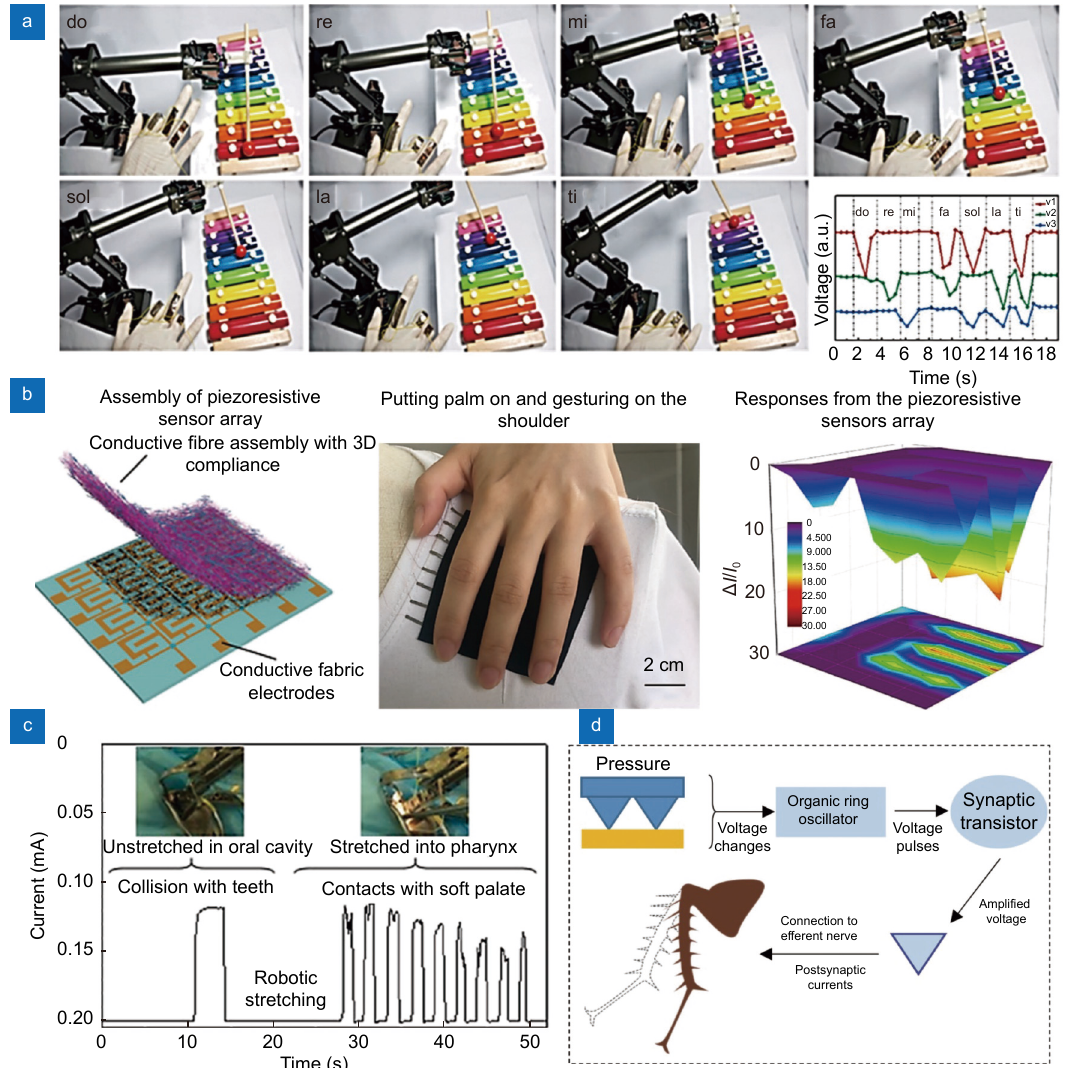
Fig. 13 | Piezoresistive sensor for prosthetics and robots. ( a ) Manipulating the robot arm by a piezoresistive sensor for music playing 169 . ( b ) Large-area force distribution detected by fibre piezoresistive sensor array 171 . ( c ) Piezoresistive sensor for the real-time monitoring of robot−tissue collision/interaction in surgical robots 173 . ( d ) Development of an artificial afferent nerve based on multiple piezoresistive sensors 175 . Figure repro- duced with permission from: (a) ref. 169 , (b) ref. 171 , (c) ref. 173 , American Chemical